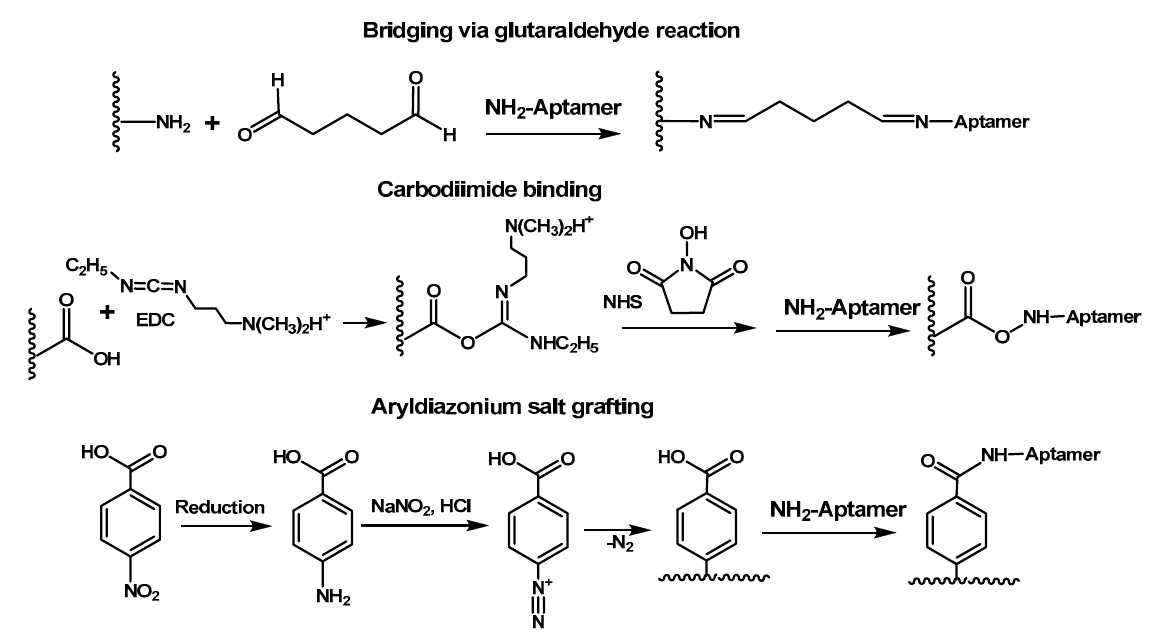
Figure 5. Glutaraldehyde cross-binding of aminated aptamer and carrier. EDC–1-ethyl − 3-(3-dimethylaminopropyl)carbodiimide, NHS– n -hydroxysuccinimide.